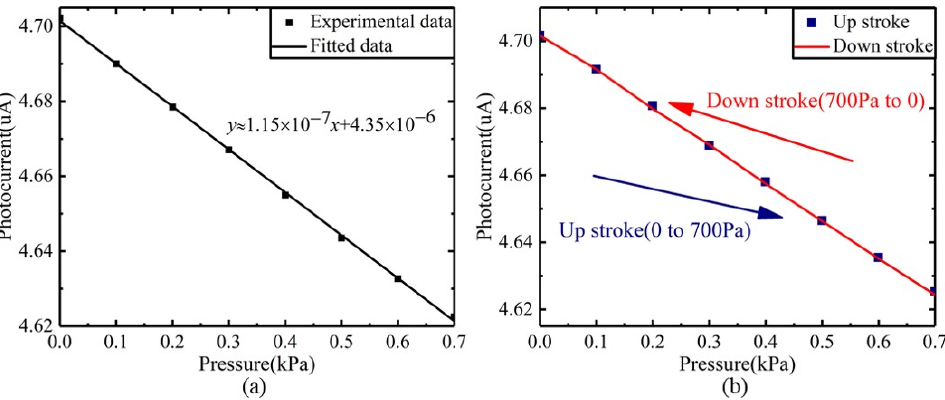
Figure 12. ( a ) The nonlinear of the sensor, ( b ) the hysteresis and repeatability of the